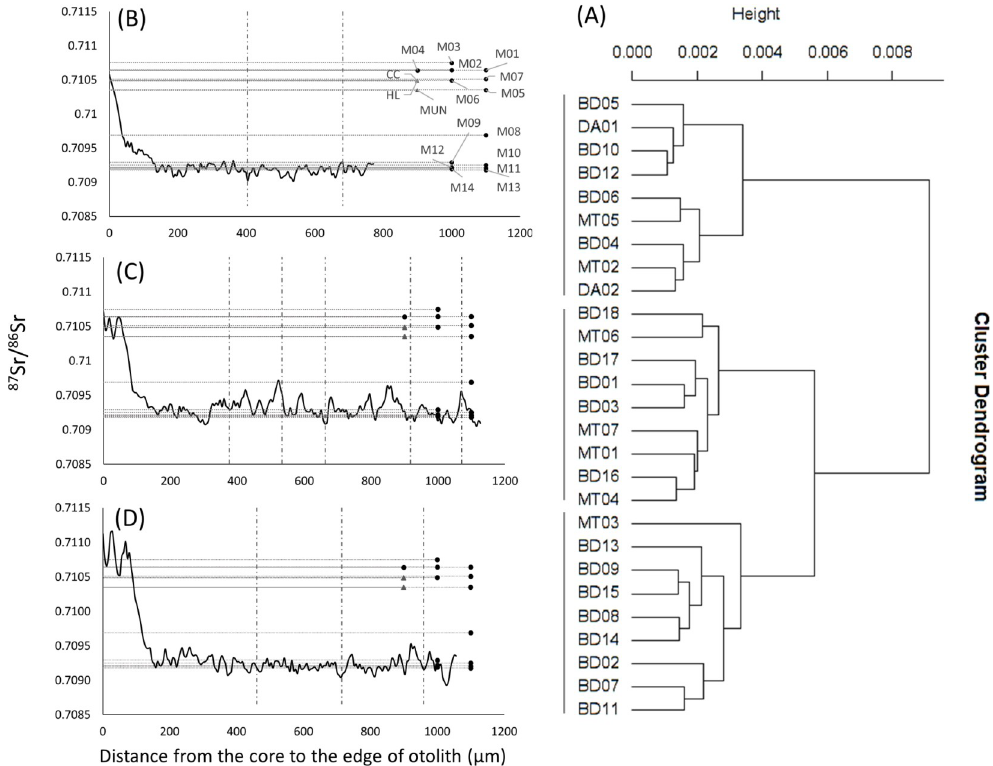
Fig 7. Main patterns of 87 Sr/ 86 Sr profiles in the otoliths of P . krempfi caught in the Mekong Delta. (A) Dendrogram of the hierarchical cluster analysis on the right. (B, C and D) on the left, three main types of 87 Sr/ 86 Sr profiles from the core to the edge of the otolith coming from the three branches of the dendrogram. Vertical dotted lines mark the end of each year based on the position of the annual growth increments. Horizontal lines correspond to the mean water 87 Sr/ 86 Sr at each sampling location in the Mekong River, except for sampling locations in the Sekong River and Tonle Sap Lake that had higher and lower values, respectively. Labels on the point on each horizontal line refer to the sampling sites (Fig 1 and Table 1). Black dots indicate Mekong mainstream sites; grey triangles indicate a tributary or